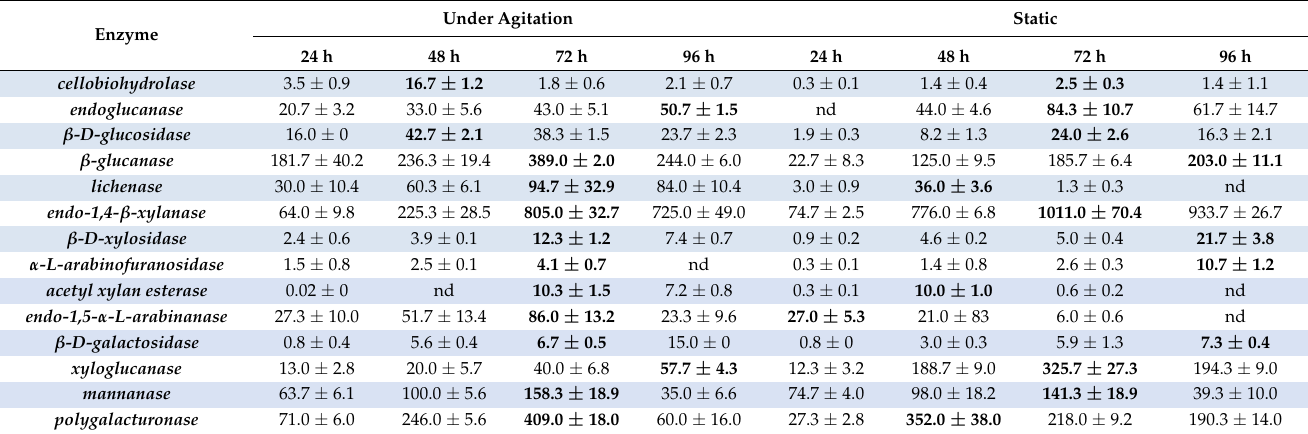
Table 4. Enzymatic activities of Trichoderma longibrachiatum LMBC 172 cultivated with tamarind seeds during different times. Enzyme